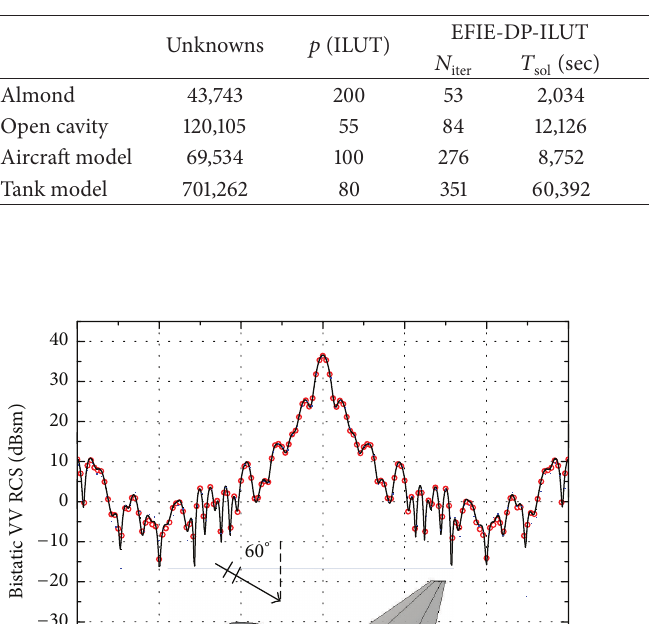
Table 3: Comparison of different integral operators and preconditioners for 3D scattering.